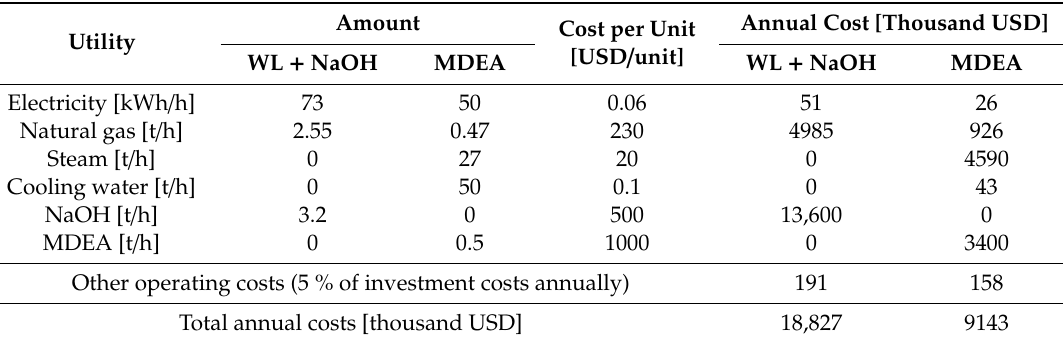
Table 13. List of utilities and operating costs estimation.